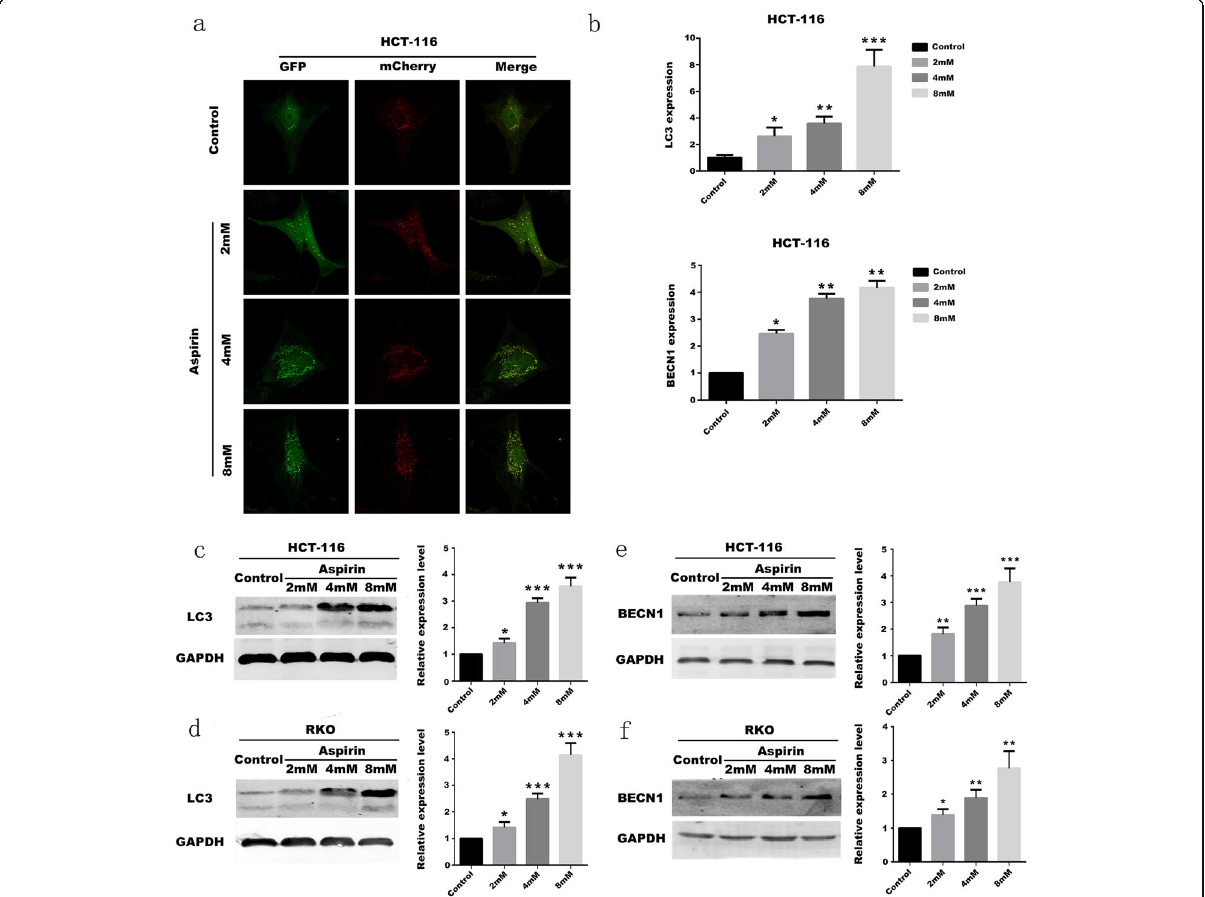
Fig. 4 Aspirin induces autophagy in CRC cells a mCherry-GFP-LC3 detects changes in autophagic flow in CRC cells treated with aspirin. b qRT- PCR was used to detect changes of MAP1LC3 (LC3) and BECN1 in CRC cells after aspirin treatment. ( n = 3) Mean ± SD. * P < 0.05, ** P < 0.01 and *** P < 0.001 (vs. normal group). c The results of MAP1LC3 (LC3) protein expression in differently treated groups in HCT-116 cells. d The results of MAP1LC3 (LC3) protein expression in differently treated groups in RKO cells. e The results of BECN1 protein expression in differently treated groups in HCT-116 cells. f The results of BECN1 protein expression in differently treated groups in RKO cells. All experiments were repeated 3 times, ( n = 3) Mean ± SD. * P < 0.05, ** P < 0.01 and *** P < 0.001 (vs. normal